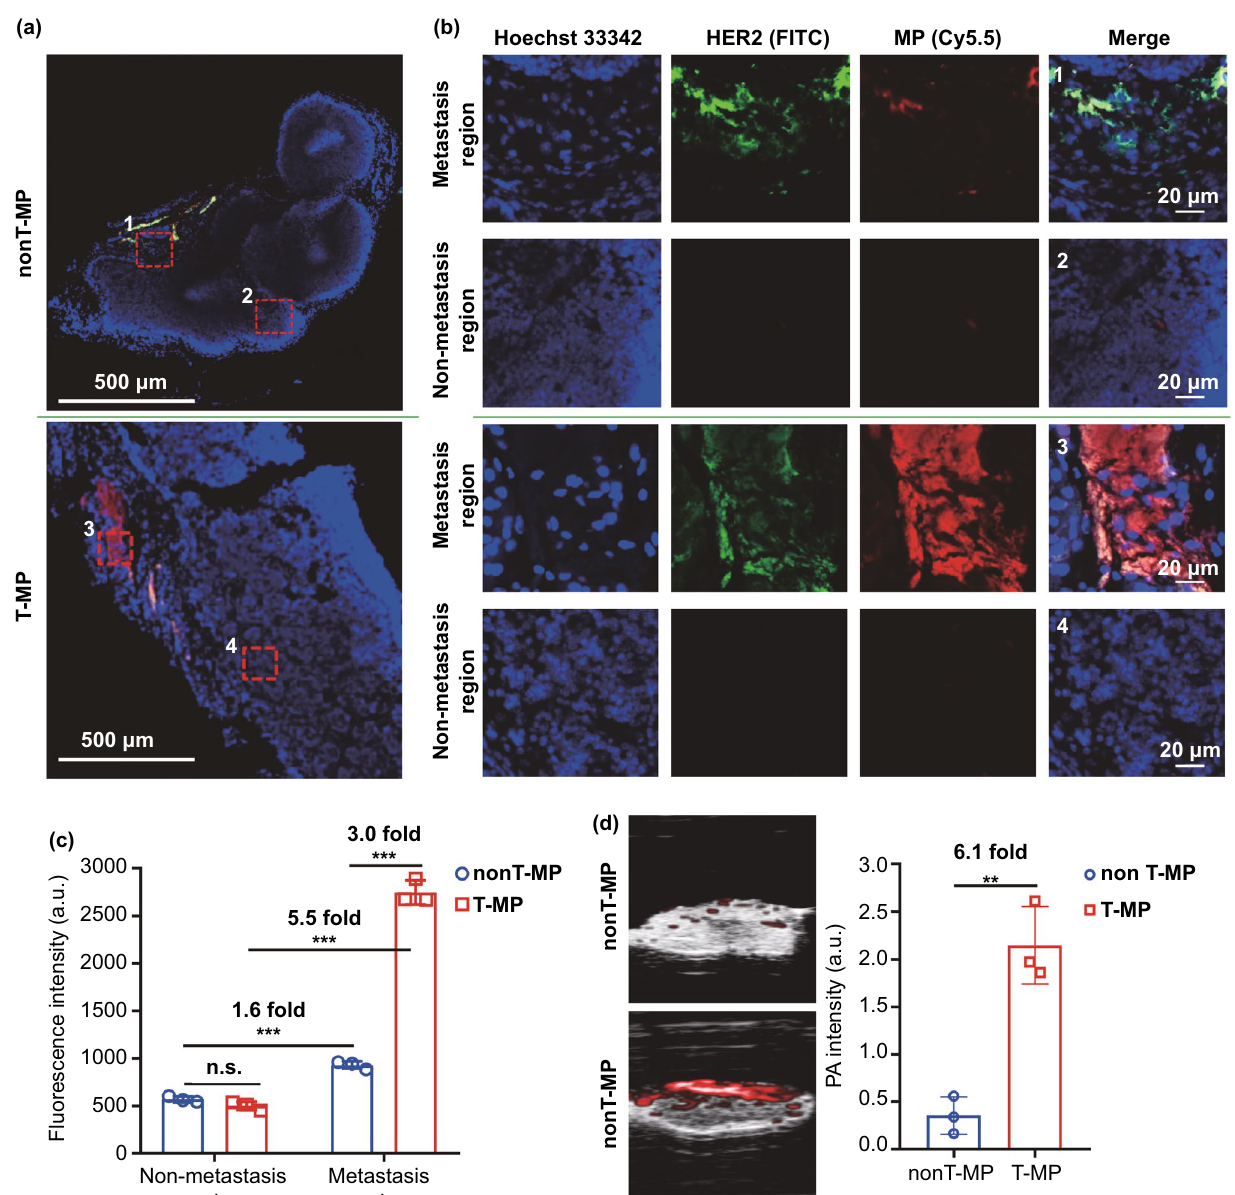
Fig. 4 Micro‑distribution of the micelles in the metastatic sentinel LNs and LN PA imaging. a Immunofluorescent staining of the metastatic sentinel LNs 8 h after i.v. injection of the T‑MP or nonT‑MP. The micelles were labeled with Cy5.5 (red) and the metastatic tumor cells were stained with rabbit anti‑HER2 antibody and FITC goat anti‑rabbit antibody (green). The region with metastasis (1 and 3) and metastasis‑free region (2 and 4) was enlarged in panel ( b ). c Quantified fluorescence intensity in panel B. n.s., not significant. d Ex vivo PA imaging of the excised metastatic sentinel LNs. Quantified PA signals were compared. Data are presented as mean ± s.d. ( n = 3). ** p < 0.01, *** p <